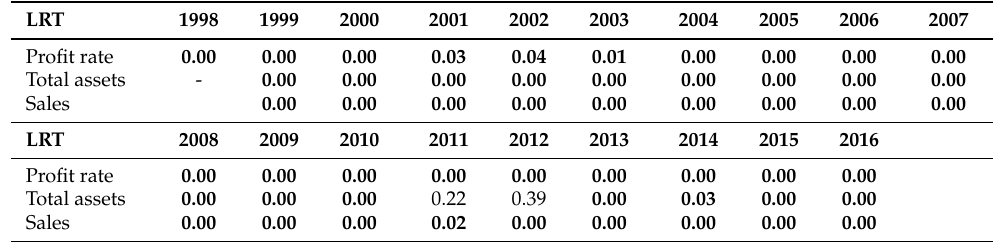
Table A2. P -values of the likelihood ratio test for profit rates and growth rates of total assets and sales. The null hypothesis is the Laplace distribution, while the alternative hypothesis is the AEP distribution. Results refer to the 200 largest long-lived firms, according to their sales in 2016. In bold, we underlined P -values below